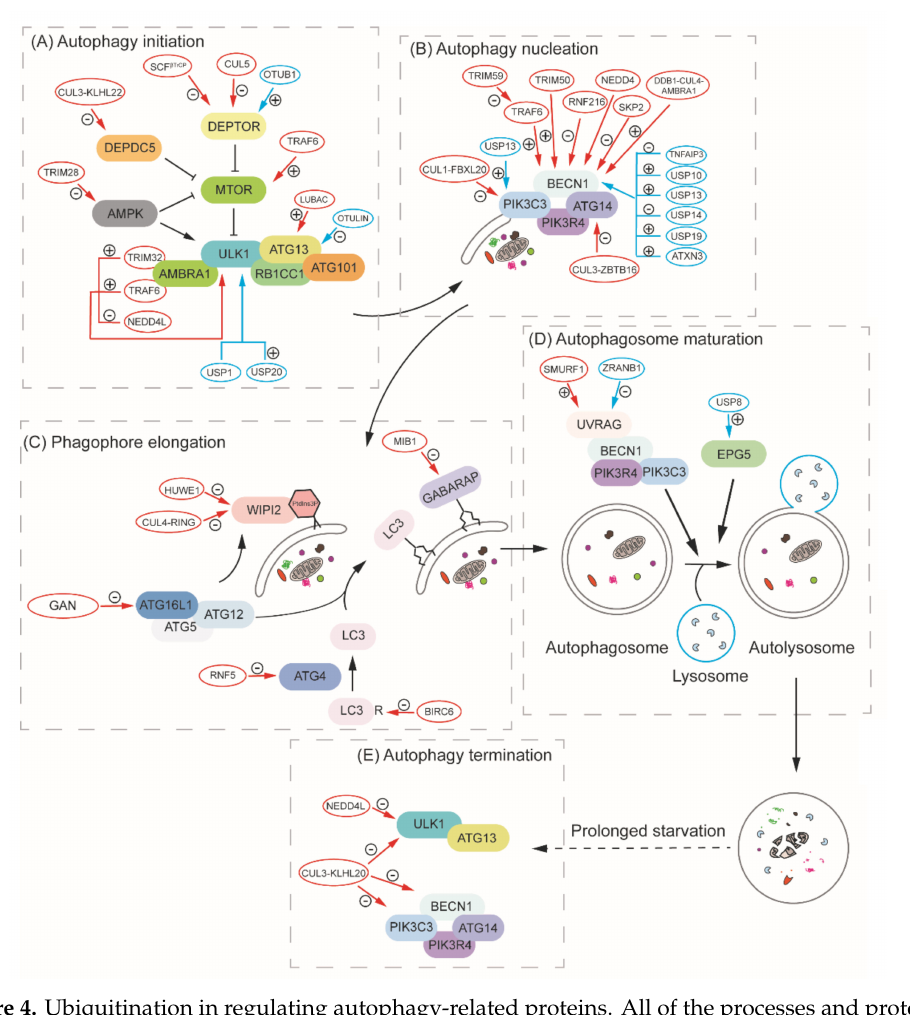
Figure 4. Ubiquitination in regulating autophagy-related proteins. All of the processes and proteins illustrated are shown for mammalian cells. ( A ) Autophagy initiation: autophagy is initiated by the inhibition of MTOR (mechanistic target of rapamycin kinase). Another energy-sensitive kinase, AMP-activated protein kinase (AMPK), is also involved in autophagy initiation through inhibiting MTOR and phosphorylating ULK1 (unc-51 like autophagy activating kinase 1) followed by the formation of a ULK1-ATG13-RB1CC1 (RB1 inducible coiled-coil 1)-ATG101 complex. During this process, MTOR, MTOR regulators, including DEPTOR (DEP domain containing MTOR interacting protein) and DEPDC5 (DEP domain containing 5, GATOR1 subcomplex subunit), AMPK, ULK1